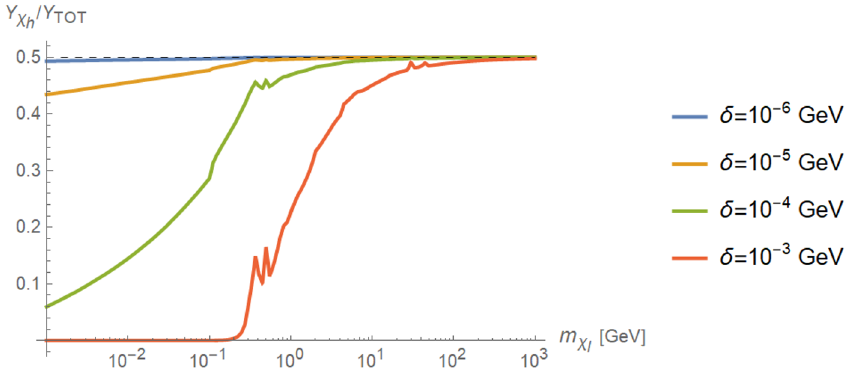
Figure 2 . This plot shows a comparison of the depletion of the excited state for different mass splittings and dark matter masses with m = 3 ( m + δ/ 2) . We consider only the depletion A 0 χ l produced by the scattering of dark matter off electrons and positrons (see figure 3 for the depletion by DM self-scattering). Note that we are considering an (cid:15) fixed for a thermal target. This value of (cid:15) depends on the total annihilation cross section which involves hadronic resonances giving rise to the observed peaks in the